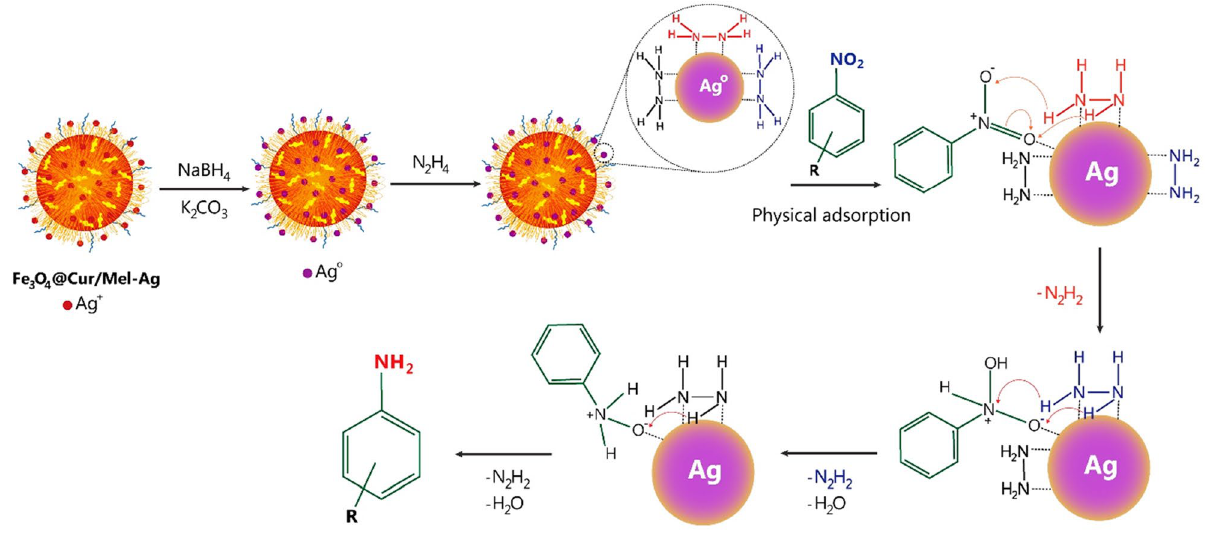
Figure 8. The plausible reaction mechanism of NB derivatives reduction to anilines by applying the Fe 3 O 4 @ Cur/Mel-Ag magnetic nanocomposite in the presence of N 2 H 4 .H 2